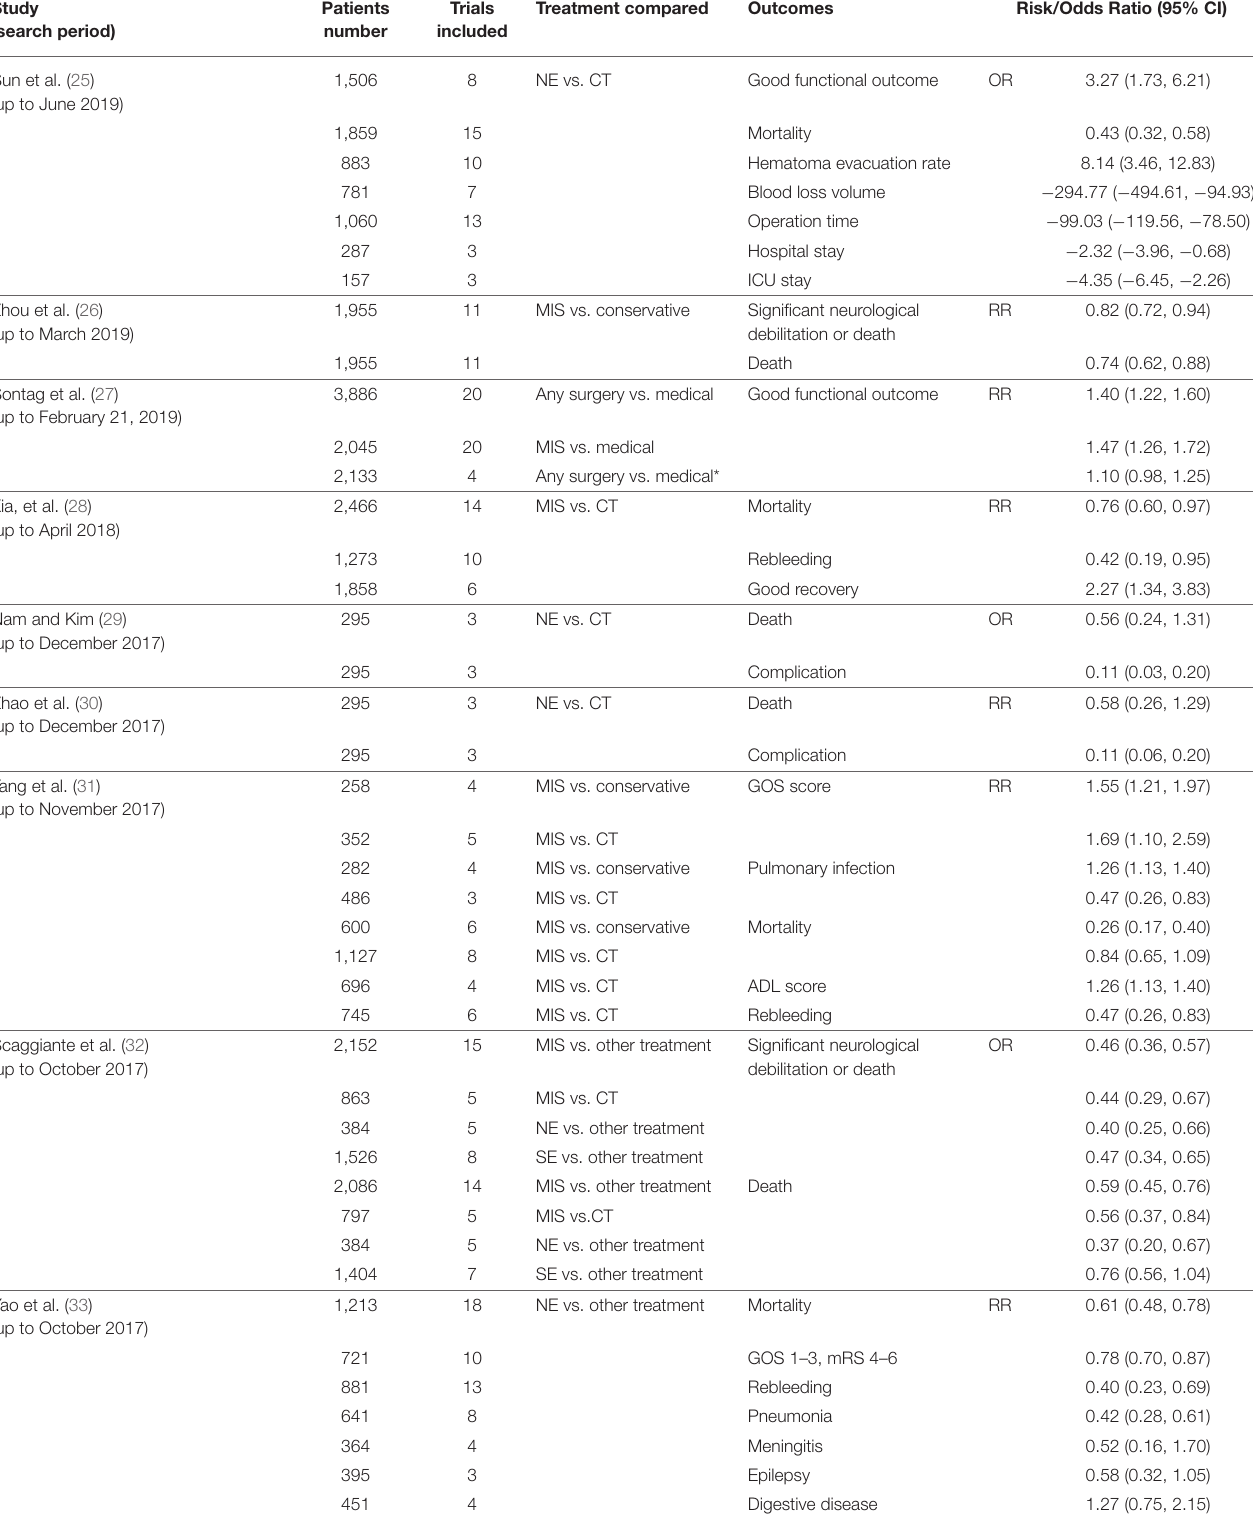
TABLE 1 | Summary of recent meta-analyses on minimally invasive surgery for intracerebral hemorrhage. Study (search